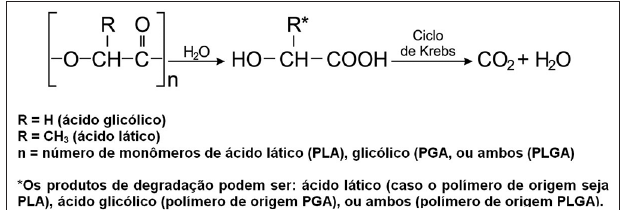
Figura 1. Mecanismo de hidrólise de PLA, PGA ou PLGA (adaptada de Merkli et al. 13 ). A presença do grupo metila (CH3) na cadeia de ácido lático de polímeros do tipo PLGA confere maior